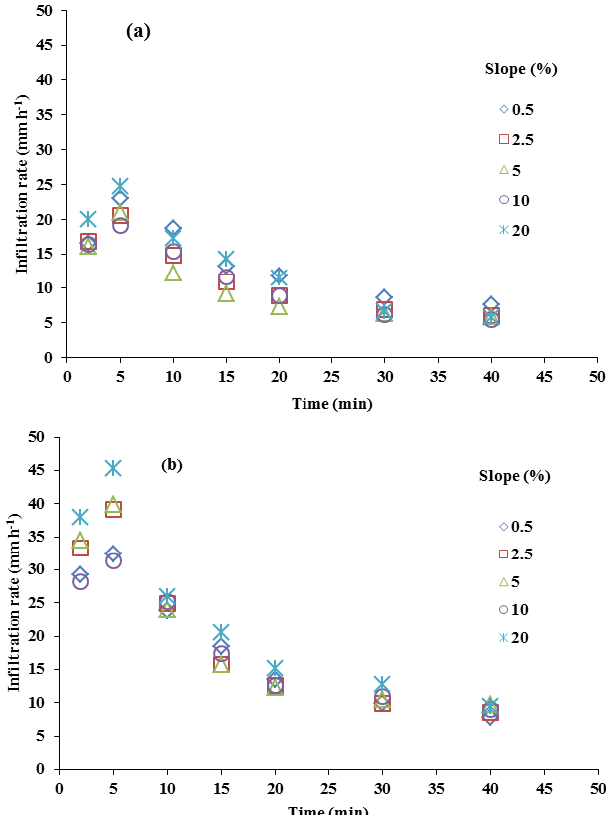
Figure 5. Time changes of infiltration rate in soil D max 2mm for different slope gradients and rain intensities of (a) 57 and (b) 80mmh − 1